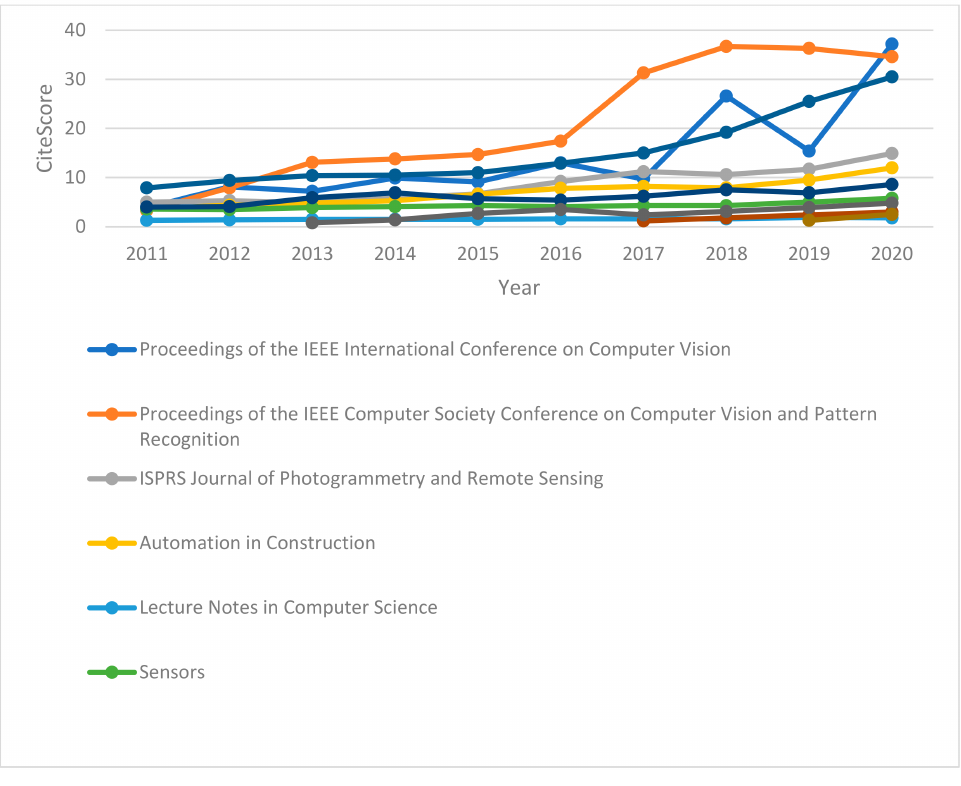
Figure 4. SCImago journal rank by